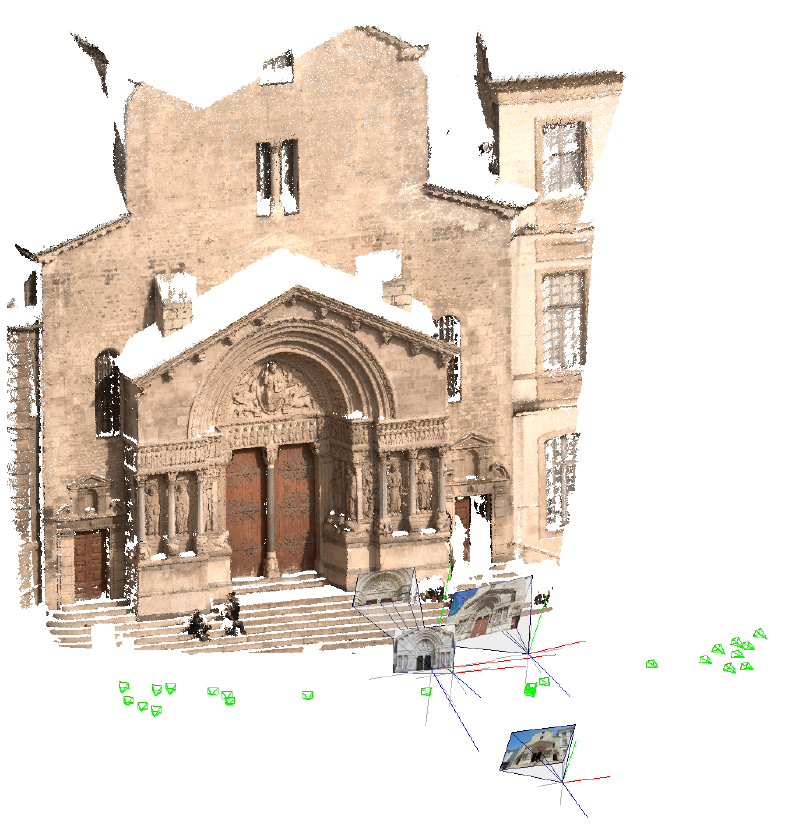
Figure A2. Saint-Trophisme dataset : spatial-Resection of a web-based